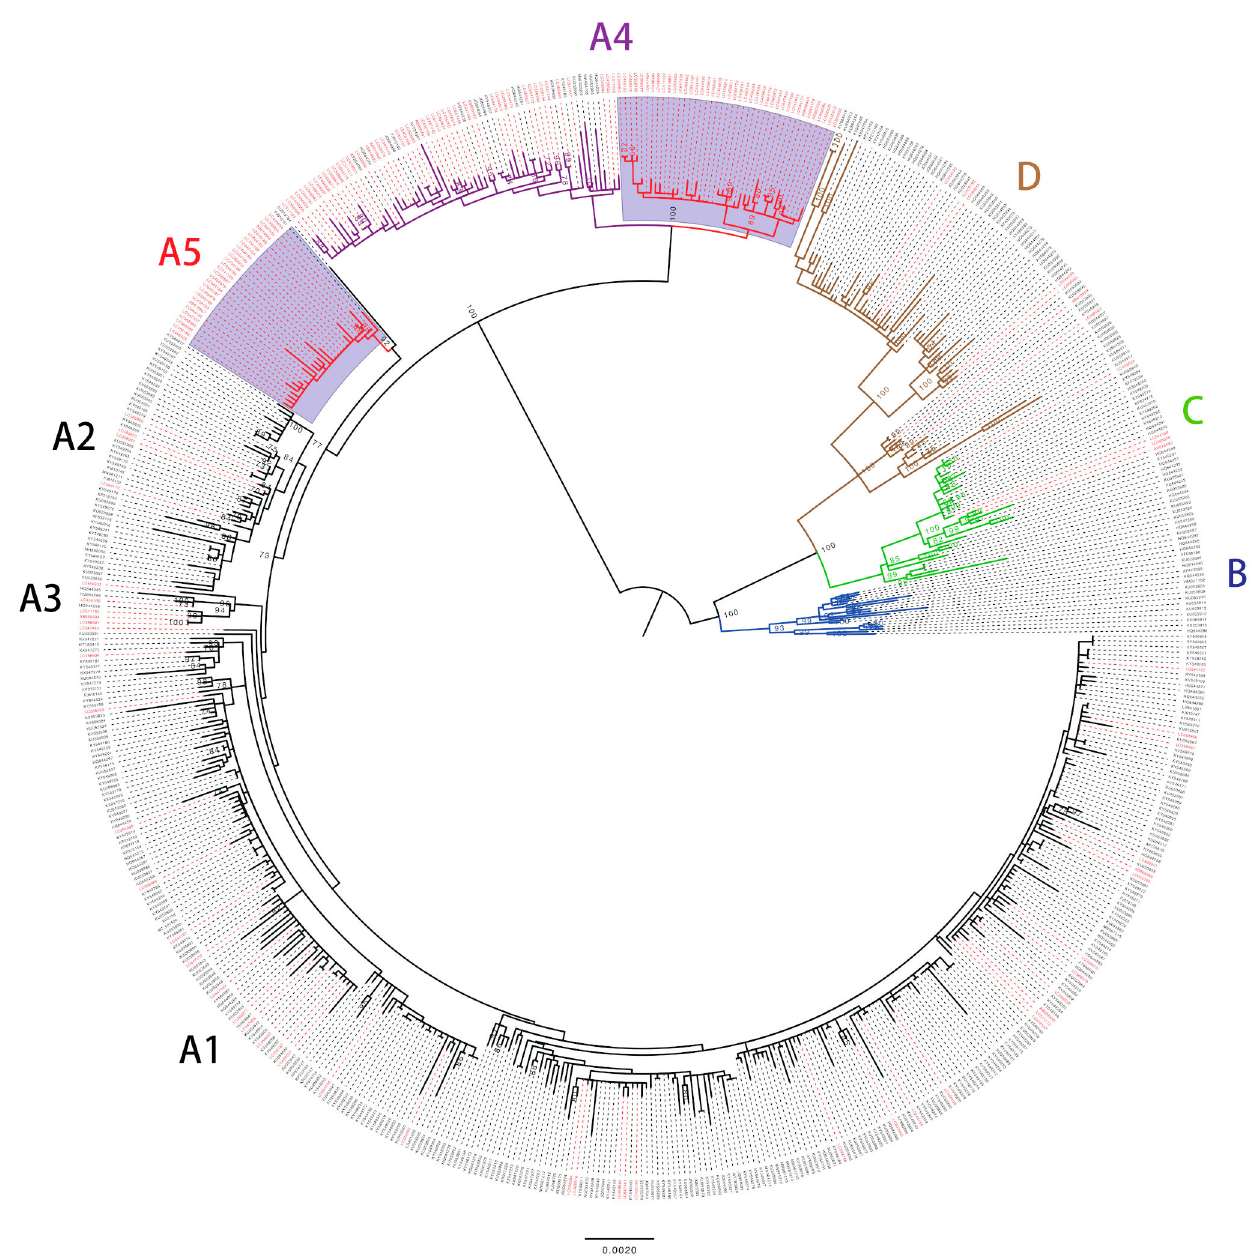
Figure 1. Maximum likelihood phylogenetic tree of complete HPV16 genomes available from Gen- Bank (https://www.ncbi.nlm.nih.gov/genbank/, accessed on 31 August 2021). A total of 627 se- quences were analyzed in RAxML with 1000 bootstrap replicates. Bootstrap values >70% are dis- played. Red taxa indicate 172 sequences from Japan. Purple area marks the Japan-specific cluster of the sublineage A4 and the cluster of the sublineage A5. Scale bar, nucleotide substitutions per site. The phylogenetic tree of a total of 146 complete genome sequences of HPV18 revealed that most of the HPV18 isolates from Japan belonged to the sublineage A1 (19/21, 90.5%) (Figure 2). Among the A1 genomes from Japan, some (7/21, 33.3%) formed a cluster distinct from other A1 genomes reported across the world, suggesting the presence of Japan-specific HPV18